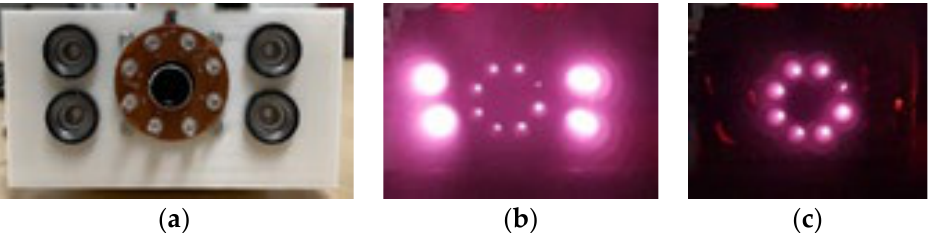
Figure 4. Implementation of broadband imaging module: ( a ) camera module, ( b ) IR flash on, ( c ) IR flash off.